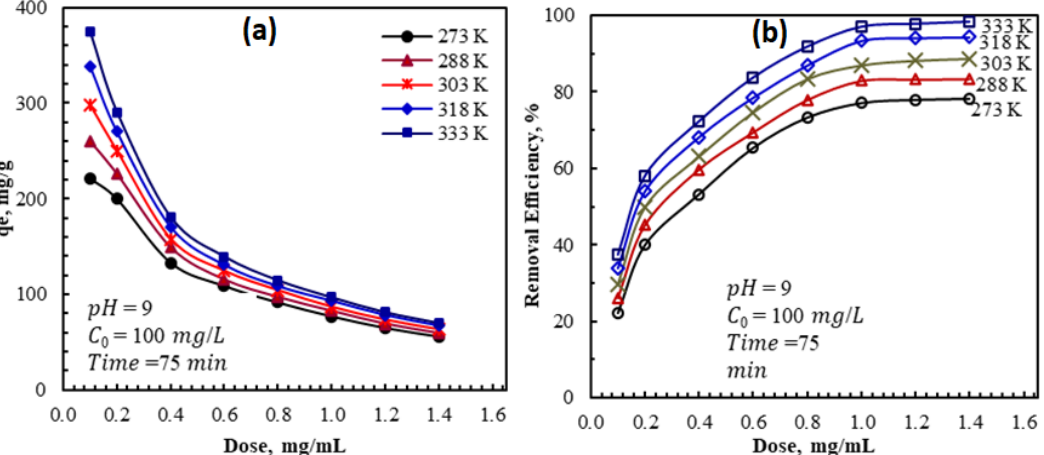
Figure 3. Effect of AFAC dosage and adsorption temperature on ( a ) the adsorption capacity and ( b ) removal efficiency of AZM by AFAC.